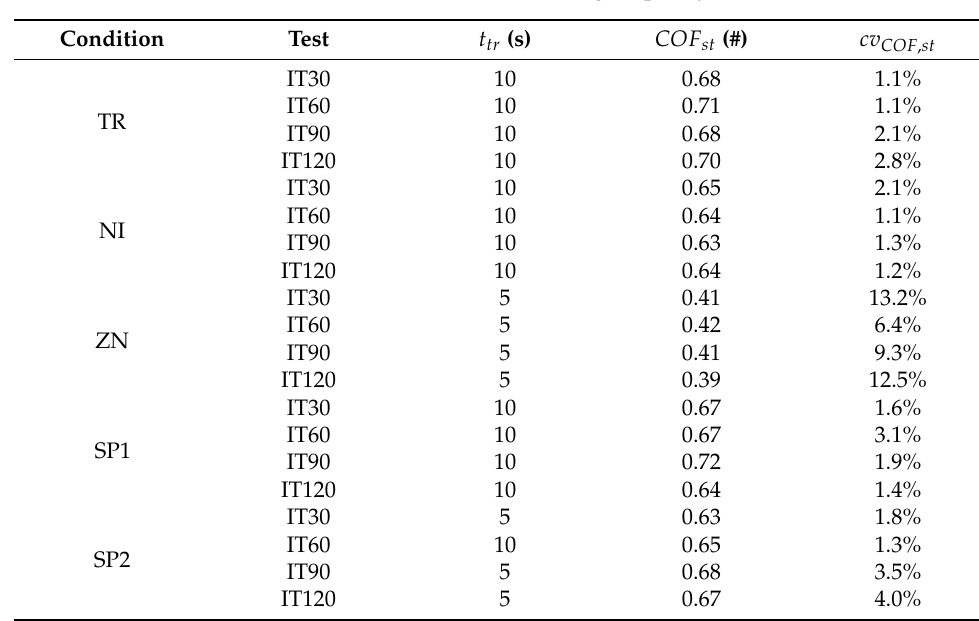
Figure 8. Evolution of COF during IT-S tests at a 1 Hz sliding frequency: ( a ) 30 s (IT30), ( b ) 60 s (IT60), ( c ) 90 s (IT90), and ( d ) 120 s (IT120). Table 7. Variation of t tr , COF st , and of cv COF at 1 Hz sliding